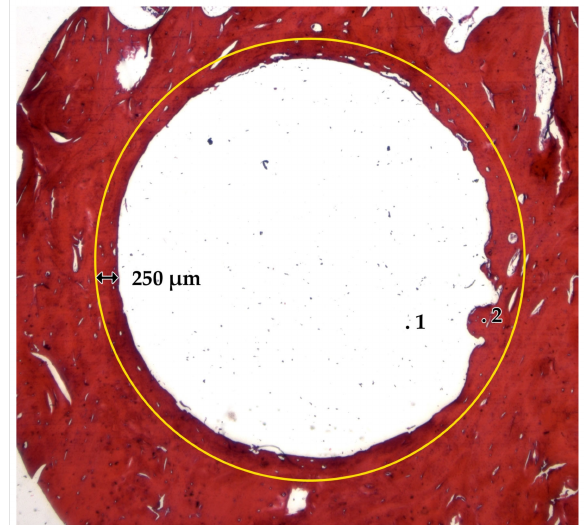
Figure 10. Decalcified and HE stained sections with a ROI of 250 µ m (yellow circle). Biomaterial body (1) is in close contact to the surrounding bone